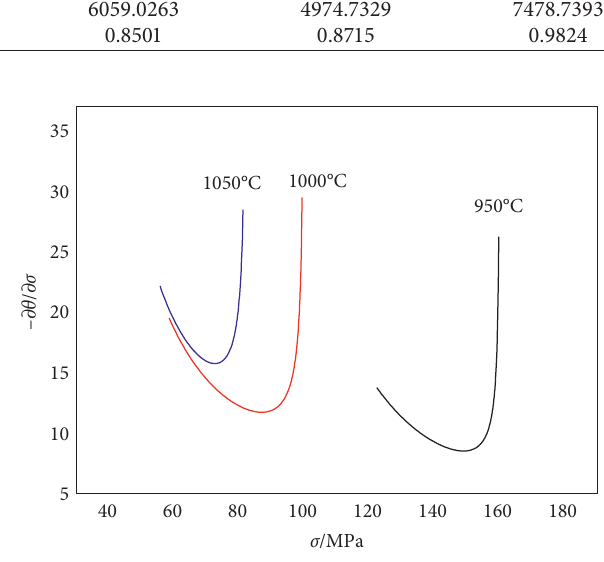
Table 2: The value of b fitted at different strain rates and temperatures. Fitted parameter